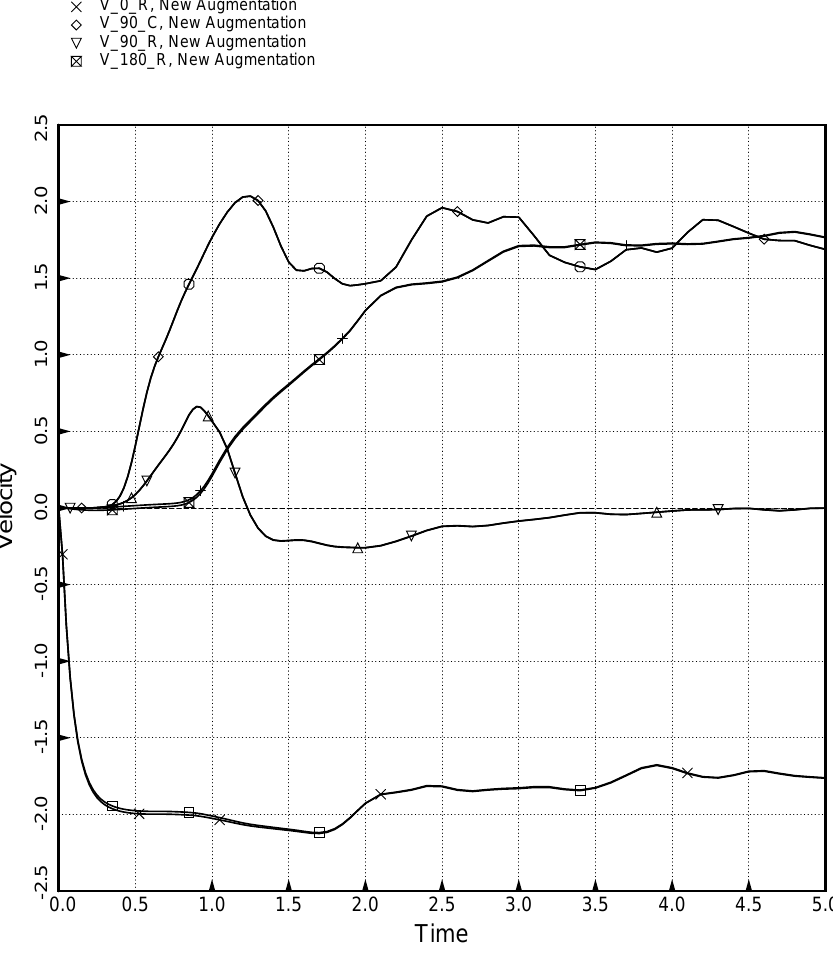
Fig. 1. Cylinder, DAA 1, Nonsingular